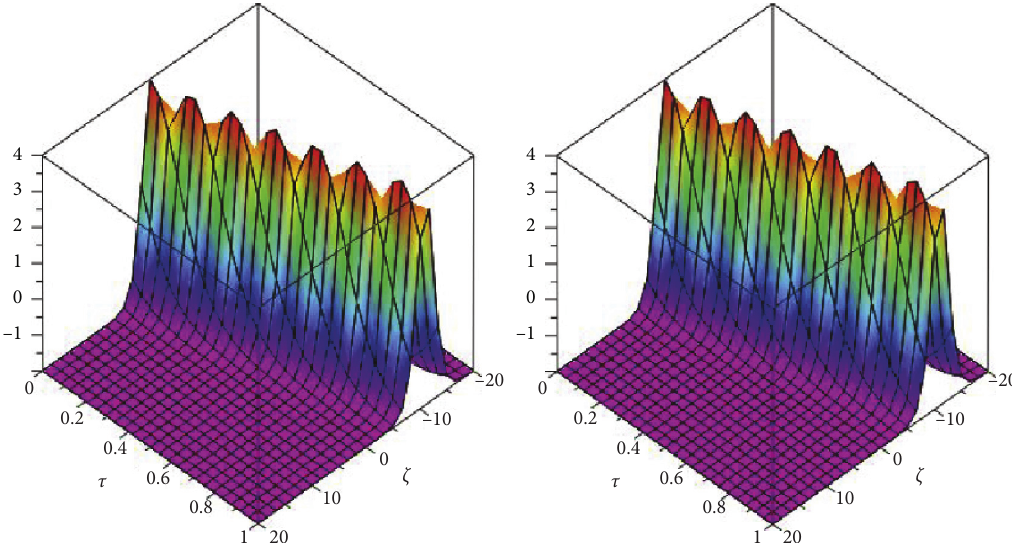
Figure 6: The exact and analytical solutions of Example